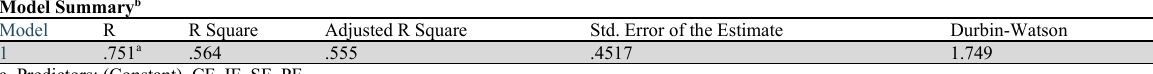
Source: Survey data